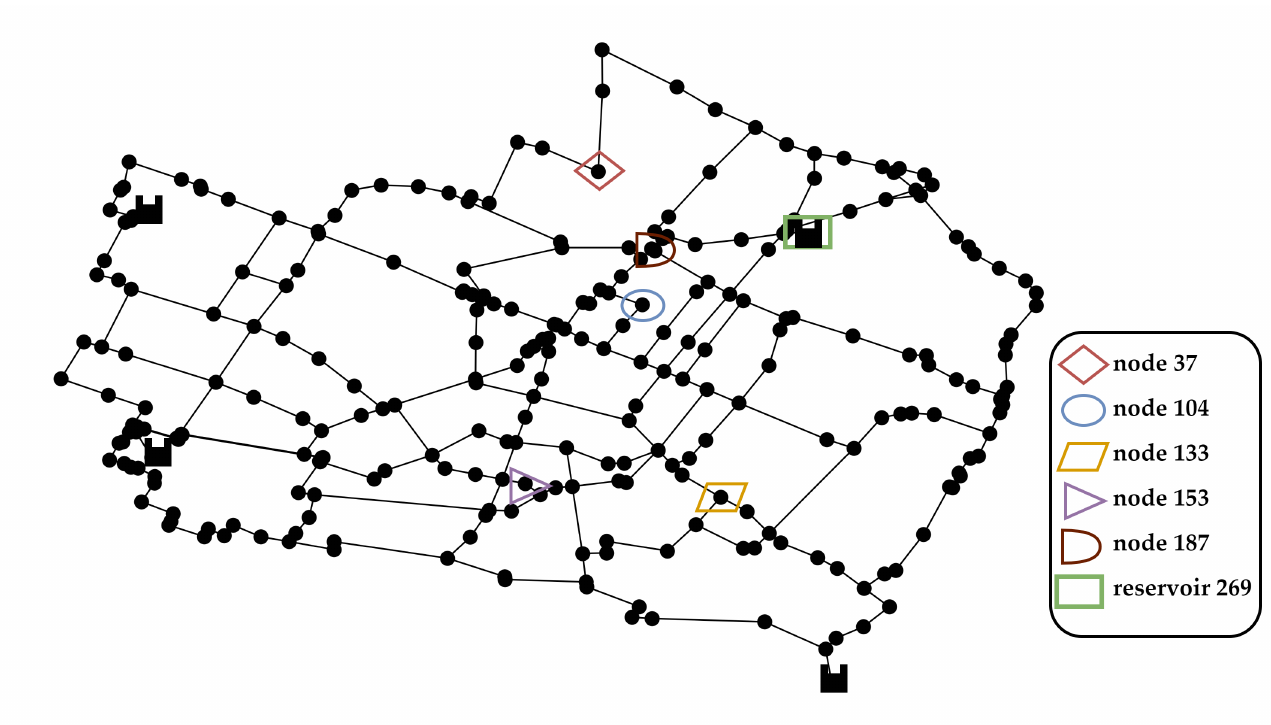
Figure 1. Modena network.